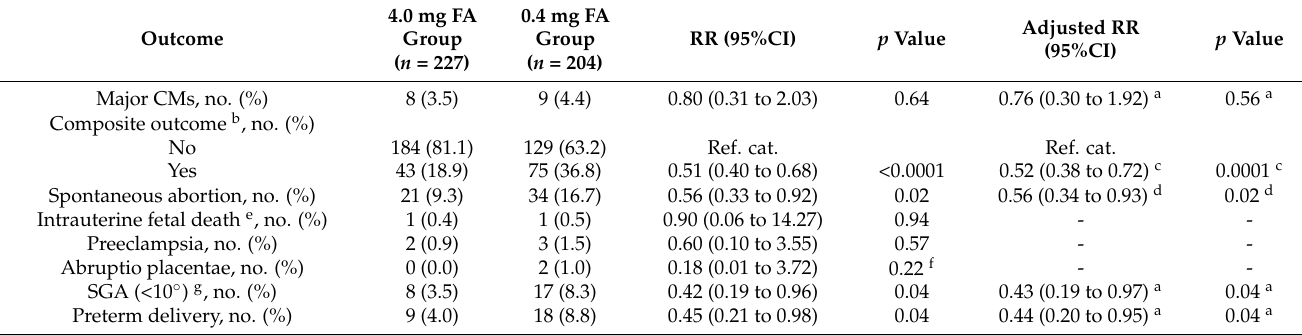
Table 2. Primary, composite, other adverse pregnancy outcomes.